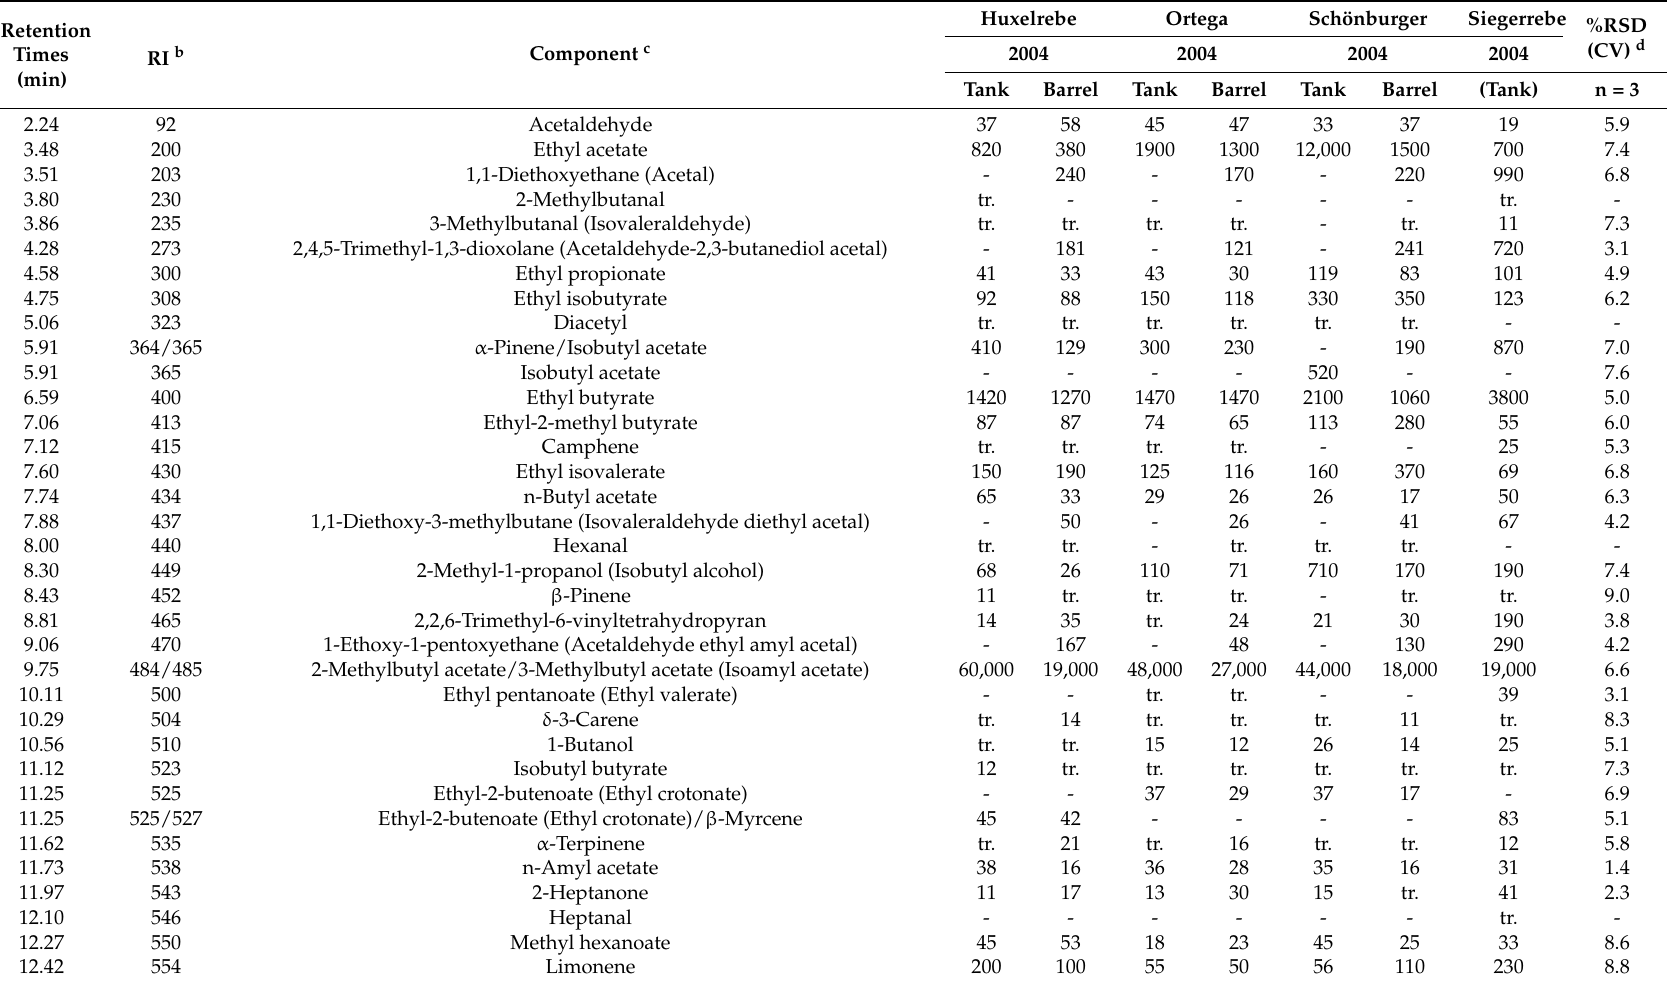
Table 2. Volatile compounds a identified in stainless steel tank- and barrel-fermented/aged 2004 Huxelrebe, Ortega and Schönburger wines, and stainless